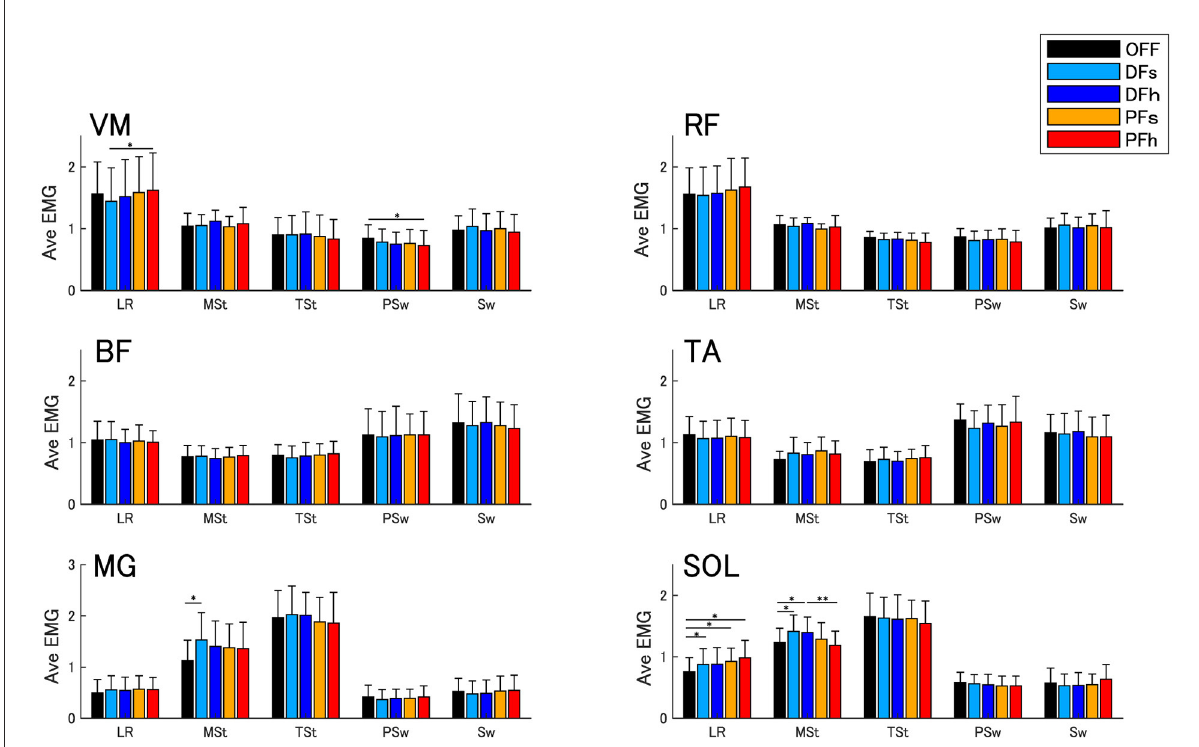
FIGURE3 Averaged EMG activities. Error bars indicate standard deviations (SD). The single asterisk (*) indicates a significance level of P < 0.05, and the double asterisk (**) indicates a significance level of P < 0.01 with Bonferroni’s correction. VM, vastus medialis; RF, rectus femoris; BF, biceps femoris; TA, tibialis anterior; MG, medial head of gastrocnemius; SOL, soleus; LR, loading response phase; MSt, mid-stance phase; TSt, terminal stance phase; PSw, pre-swing phase; Sw, swing